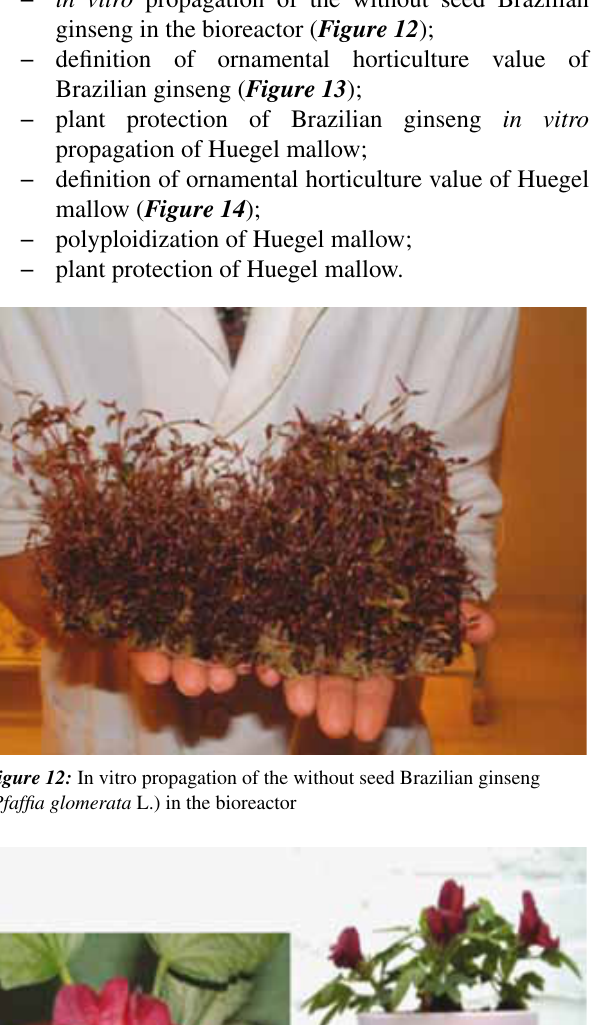
Figure 14: Definition of ornamental horticulture value of Huegel mallow (Aliogyne